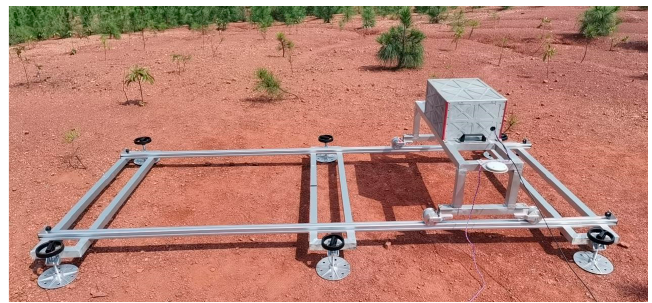
Figure 17. The designed experiment system and truss.